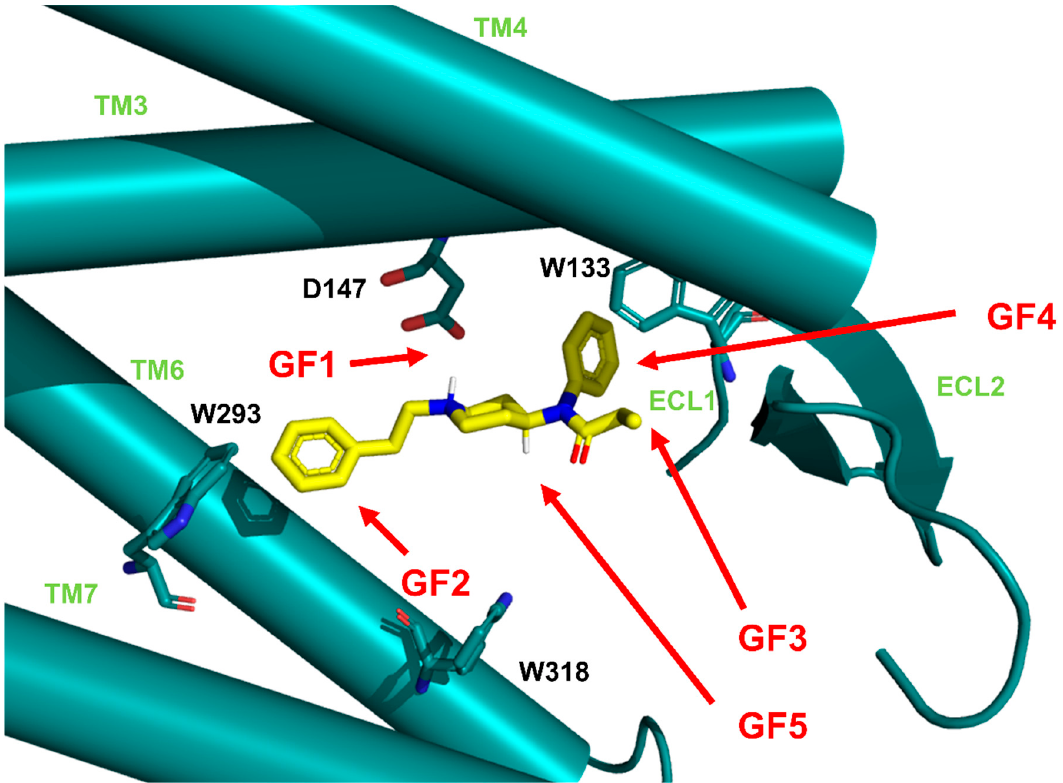
Figure 2. Fentanyl (in yellow) in the binding pocket of µ -opioid receptor ( µ OR, in light ‘Tiffany’ blue). The receptor is presented in a simplified and schematic manner with only several residues shown (labelled with black) and transmembrane helices (TM, labelled with light green) depicted as cylinders. Marked are the general features (GF, red arrows) of the binding mode common to the studied derivatives (see text for explanations).